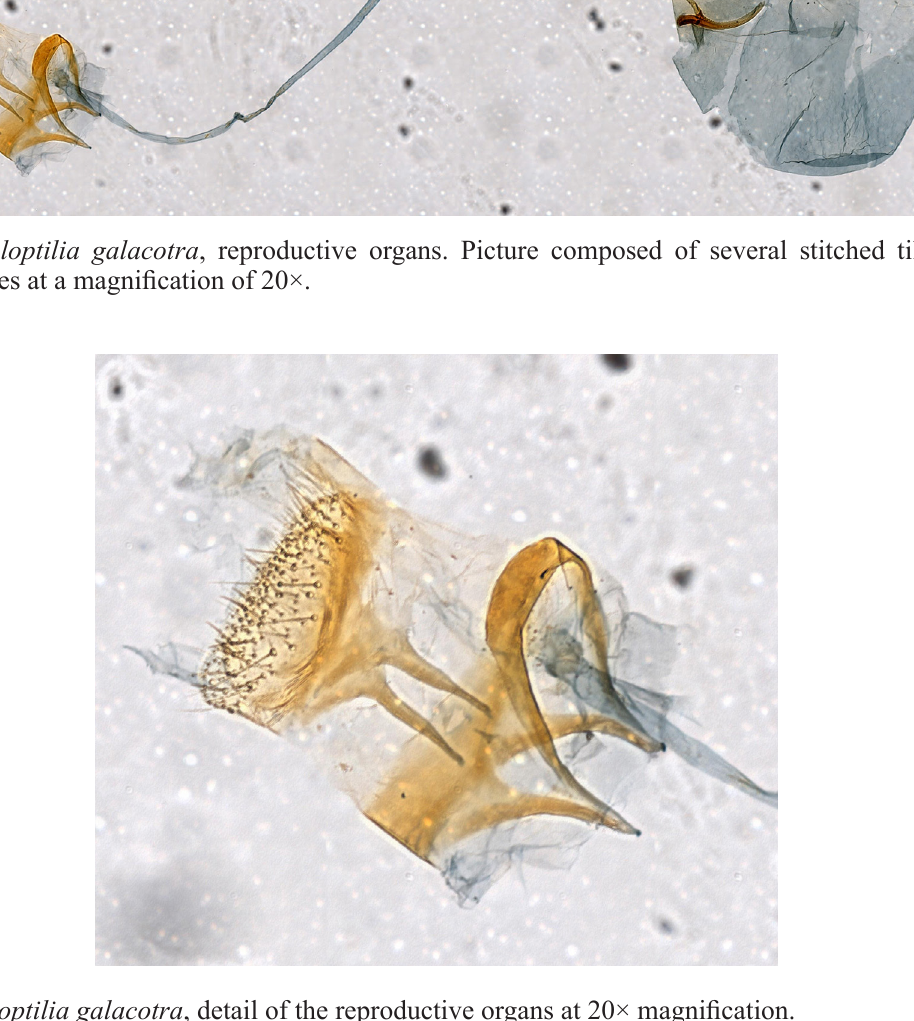
Fig. 2.16. Caloptilia galacotra , detail of the reproductive organs at 20×